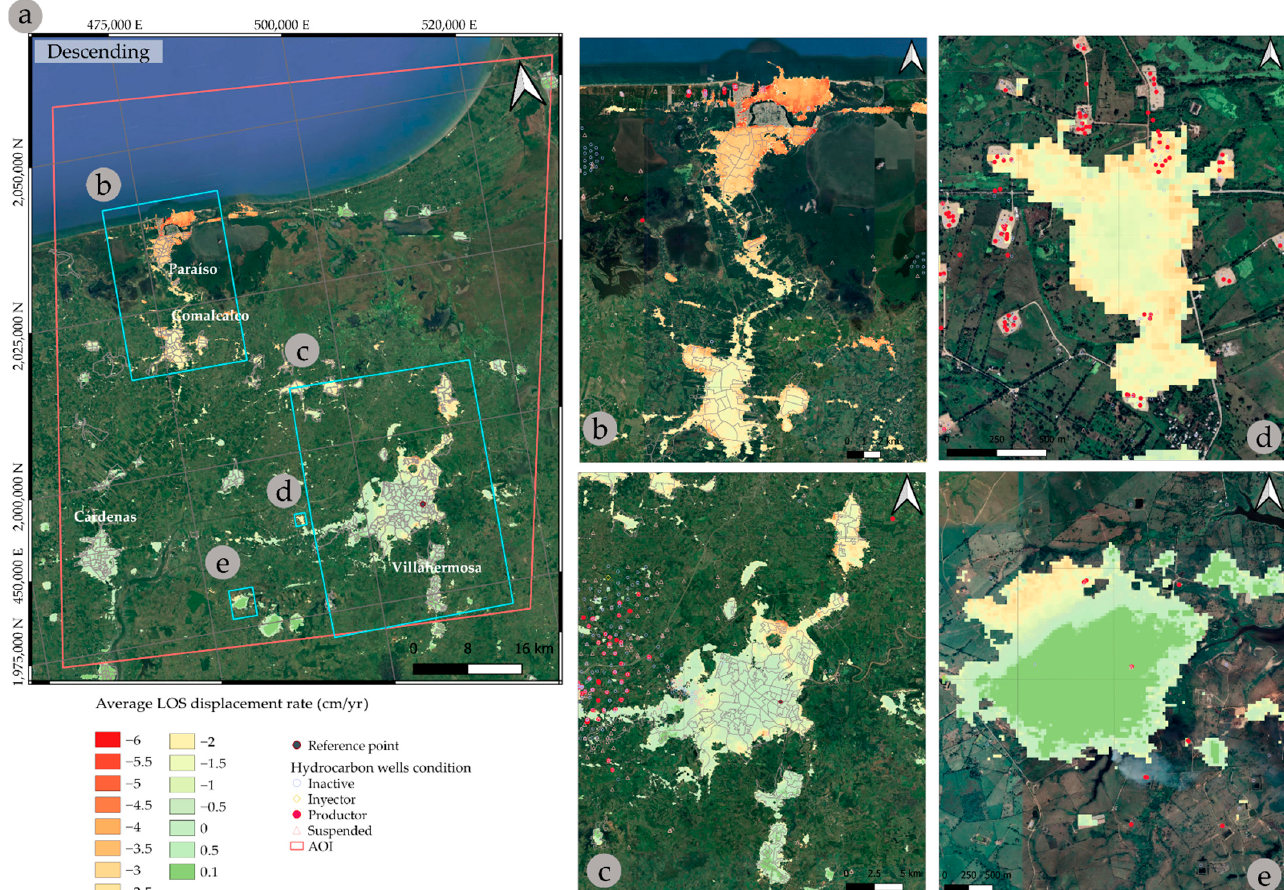
Figure 13. Map of the average LOS displacement rate (cm/yr) obtained through the DIS approach using the Sentinel-1 SLC images of the descending orbital pass acquired in 2018–2019 period. Negative values indicate a movement away the satellite. ( a ) Full AOI map. Blue rectangles enclose the zones with a higher average LOS displacement rate. Close-ups of the ( b ) Paraíso and Comalcalco, ( c ) Villahermosa, ( d ) Batería Samaria and ( e ) Batería Cactus zones are presented. The location of hydrocarbon wells is also shown.